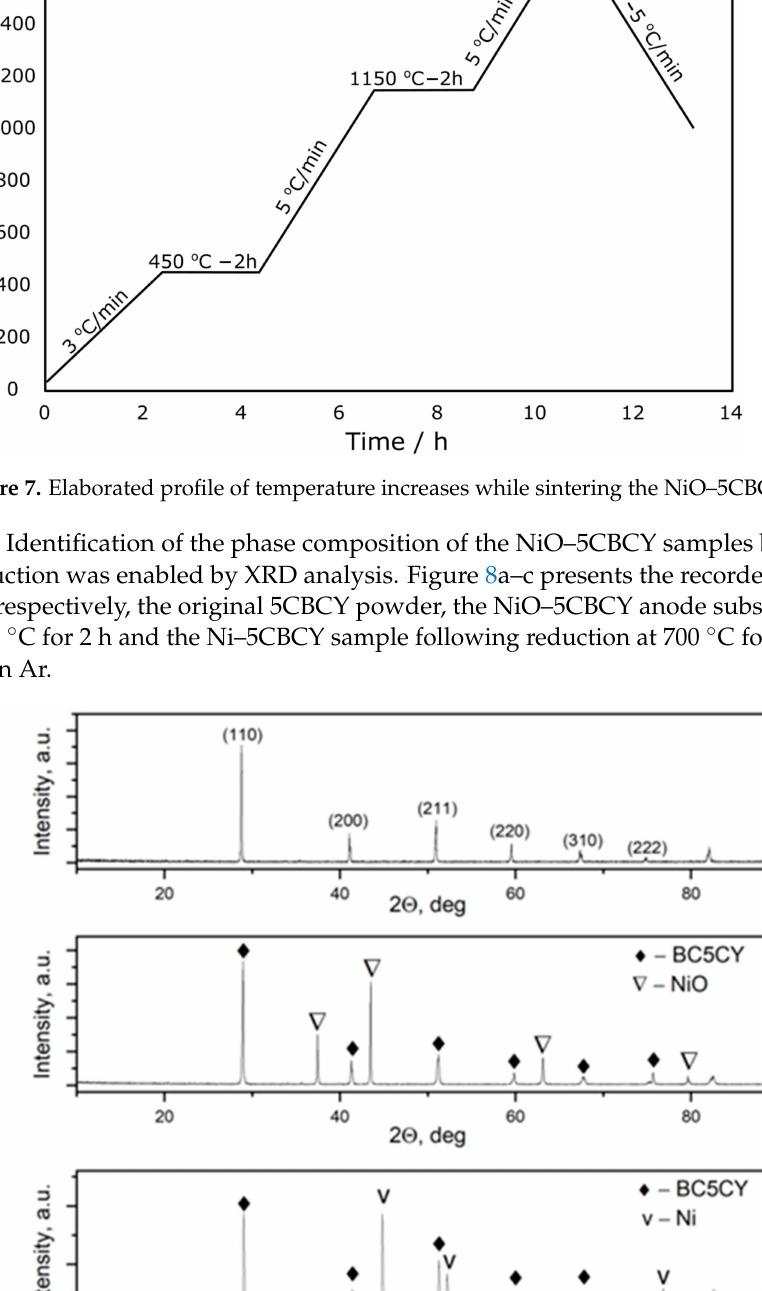
Figure 8. X-ray diffraction (XRD) patterns recorded for: ( a ) 5CBCY; ( b ) NiO–5CBCY anode substrate; ( c ) Ni–5CBCY anode